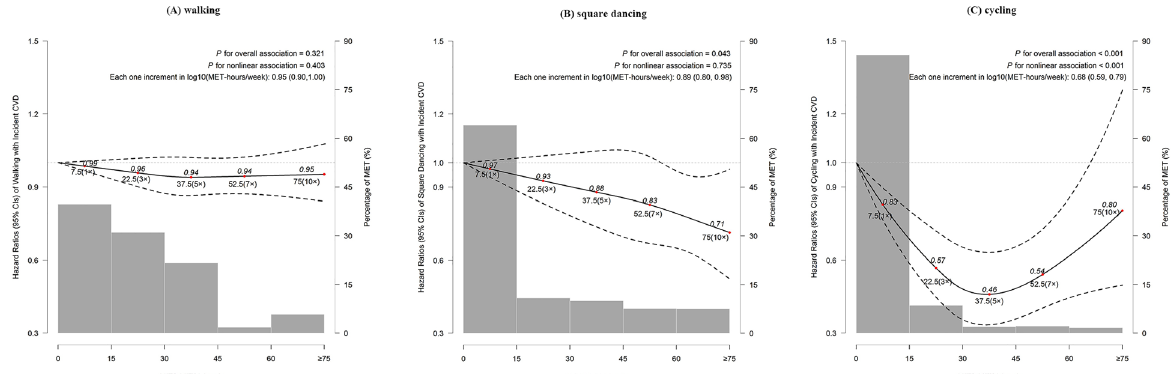
Figure 2. Adjusted hazard ratios for CVD according to levels of different types of leisure-time physical activity. ( A ) Association between walking and incident CVD. ( B ) Association between square dancing and incident CVD. ( C ) Association between cycling and incident CVD. The multivariable models were adjusted for age, sex, education, smoking status, alcohol intake, consumption of food (meat, vegetables, and fruit), hypertension, hyperlipidemia, diabetes, BMI, total sedentary time, other LTPA, and family history of